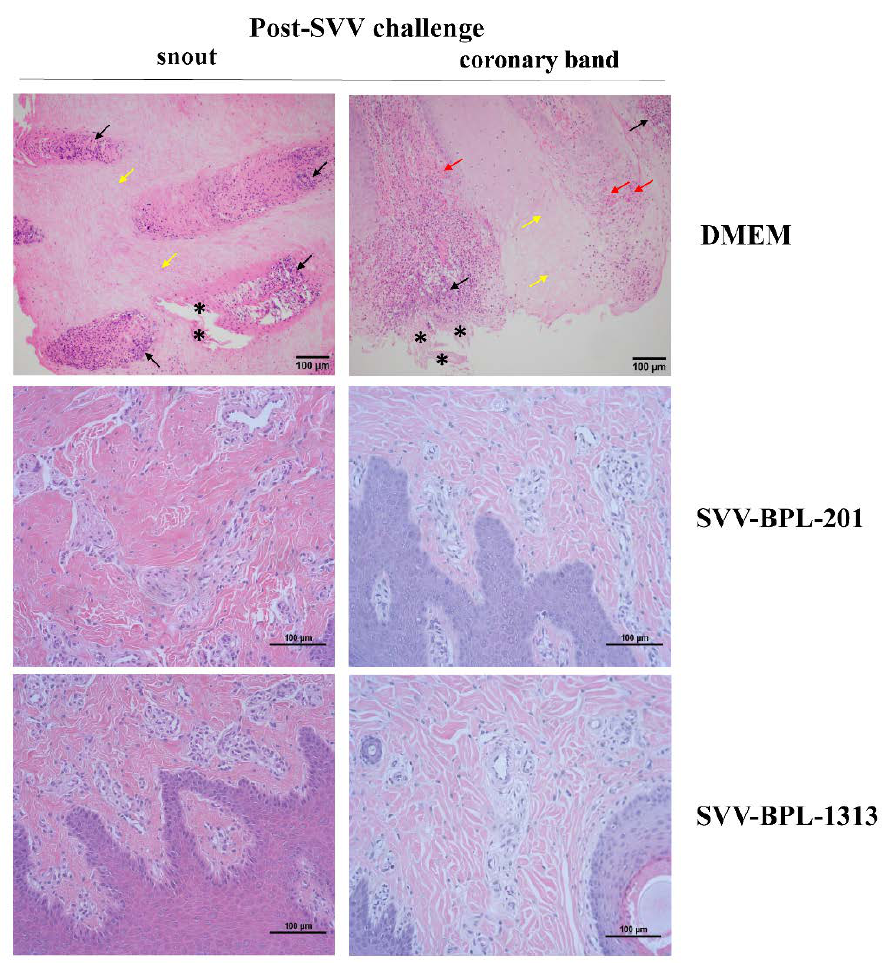
Figure 5. Histopathological analysis of pigs, post-challenge infection. Histopathological examination of the tissue of pigs challenged with the SVV LNSYO1-2017 strain. Original magnification, 200×.